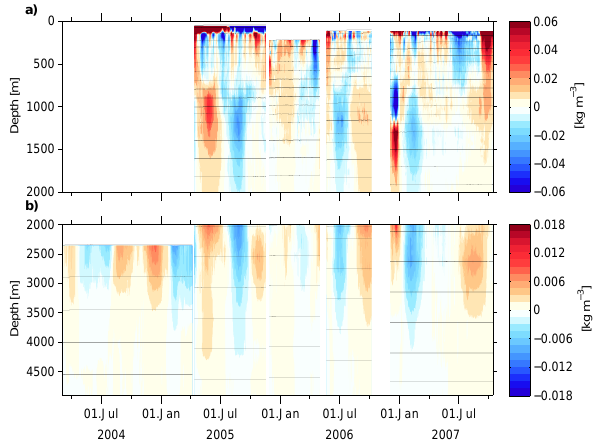
Fig. 4. 2-day low-pass filtered temperature anomaly at EB1, (a) from 0 to 2000m and (b) from 2000m to the bottom. Dates go from 4 March 2004 to 14 October 2007. For clarity, the anomalies computed around the time mean for each deployment period are shown. Note that panels (a) and (b) have different color scales. Horizontal lines are the levels of the